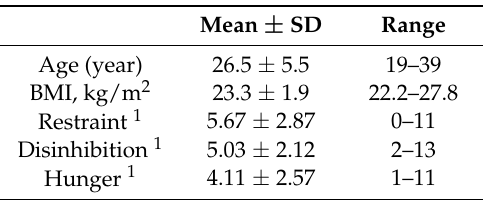
Table 3. Baseline characteristic of the participants.